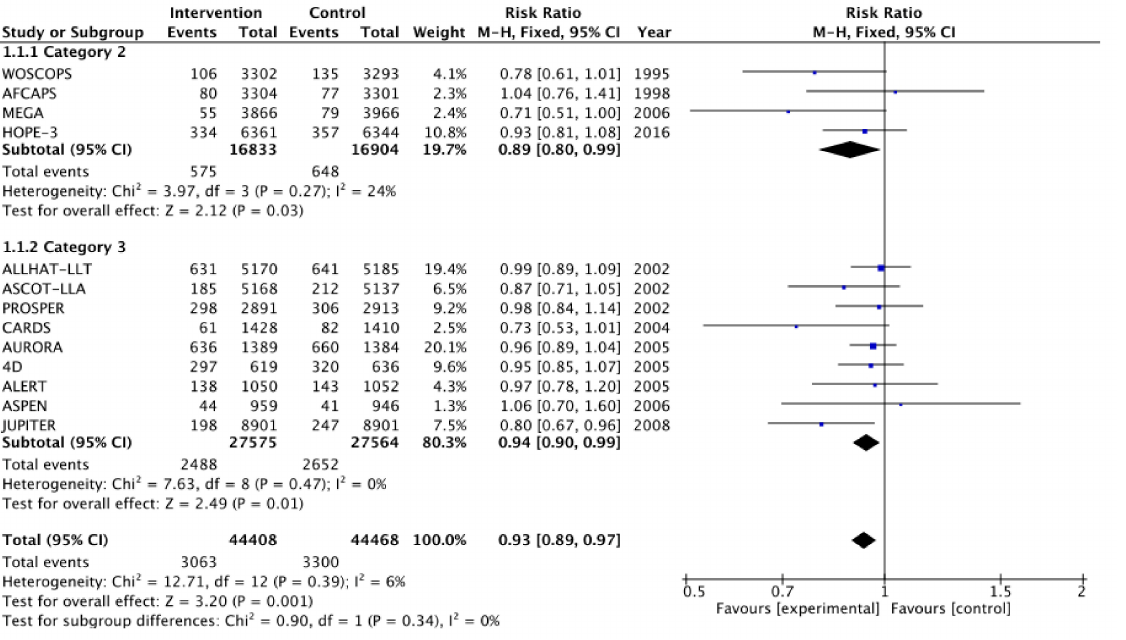
Figure 2. Relative risk across Category 2 and 3 studies for the primary outcome of all-cause mortality. Heterogeneity across studies was low, so fixed effects were used for the meta-analysis (Heterogeneity: Chi 2 = 12.71, p = 0.39, I 2 = 6%).